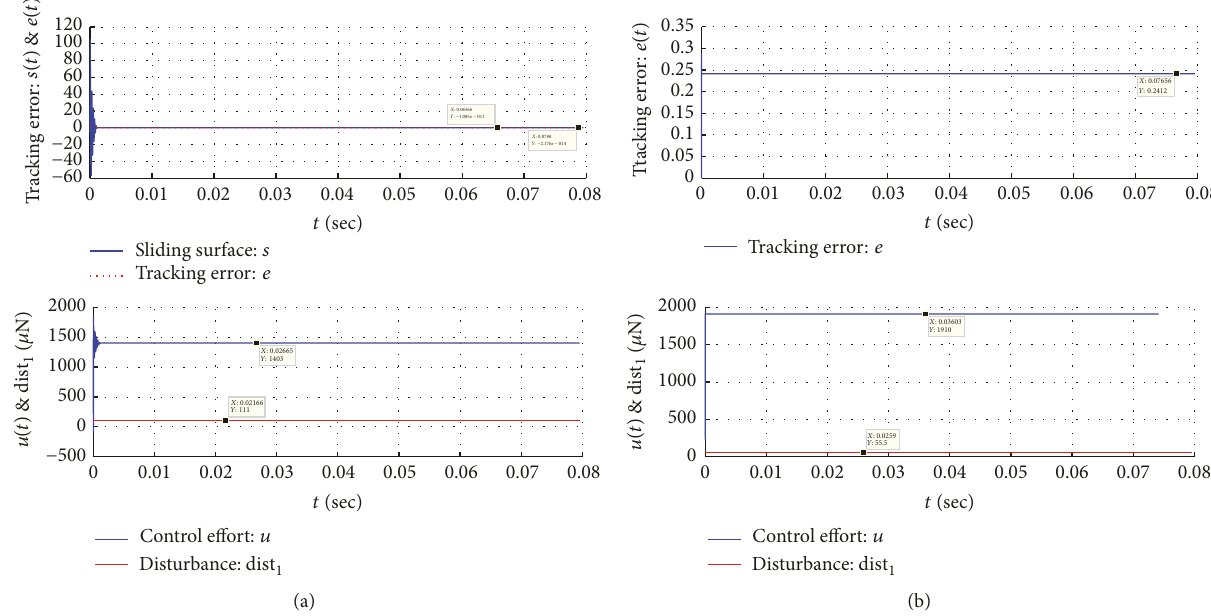
Figure 5: Tracking performance comparison between adaptive sliding mode controller and pole-placement state feedback one, both being susceptible to various malfunctioning effects: (a) tracking performance of adaptive sliding mode controller being prone to parameter uncertainty and constant disturbance; (b) tracking performance of pole-placement state feedback controller being prone to parameter uncertainty and constant disturbance.